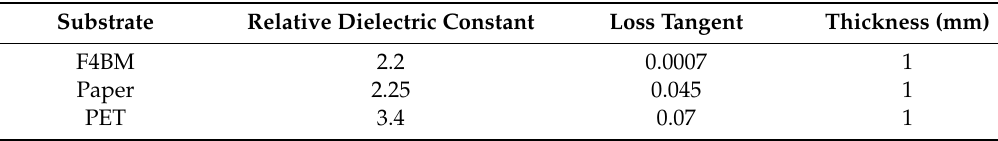
Table 5. Parameters of dielectric materials.